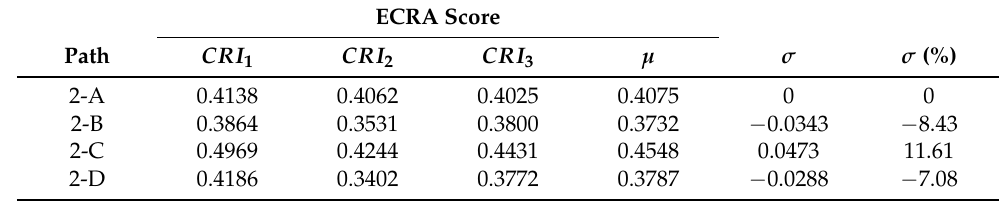
Table 4. ECRA scores in test case 2 for four proposed scenarios using three different CRI methods.